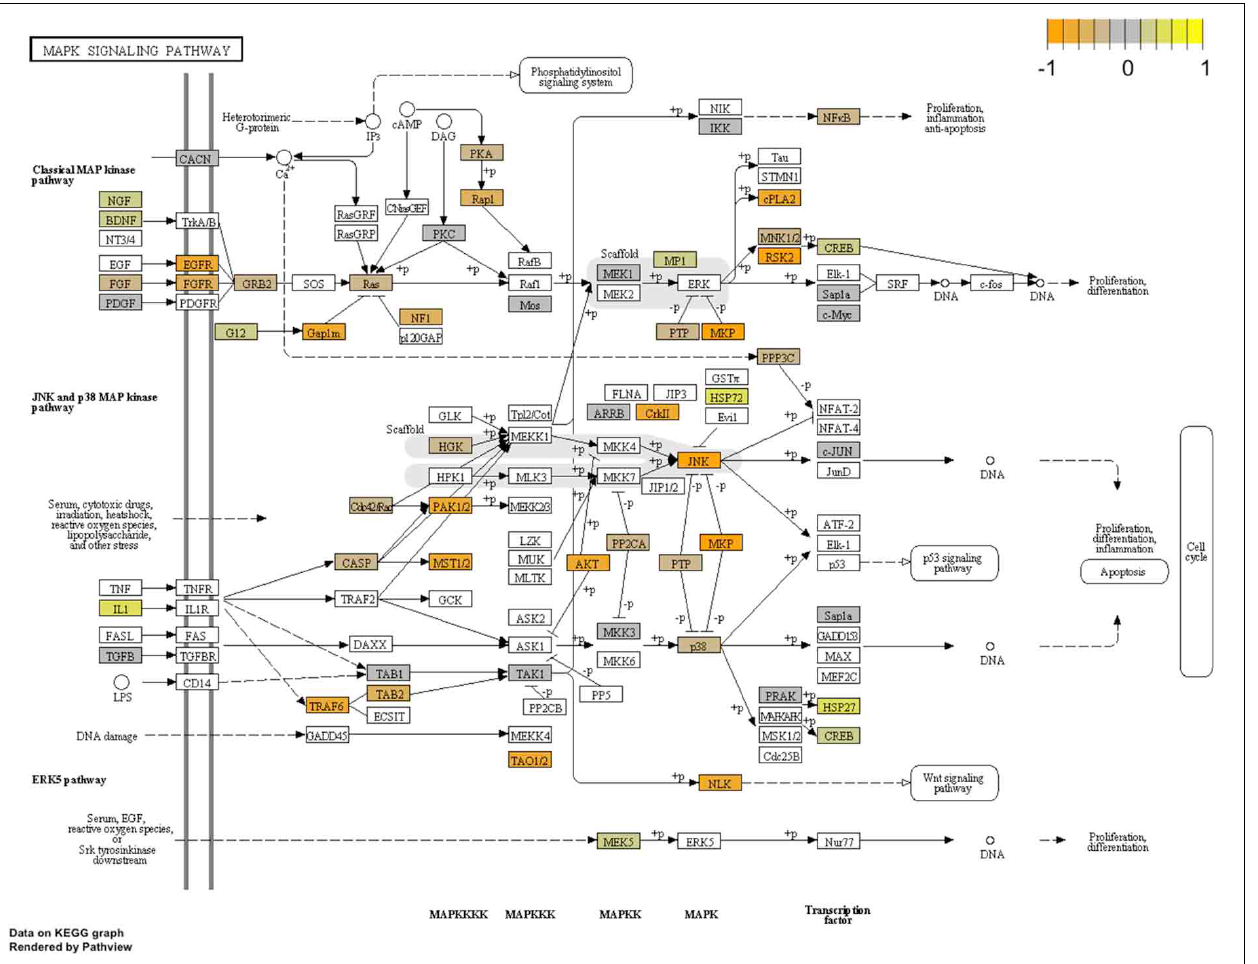
FIGURE 5 | Mapping of RNA-seq data to MAPK pathway (KEGG). The figure shows the complete pathway as annotated in KEGG, but shading (orange, gray, yellow) is applied only to those RNAs detected in our dataset that also pass DESEQ2 statistical filters and map to a unique ENTREZ ID.